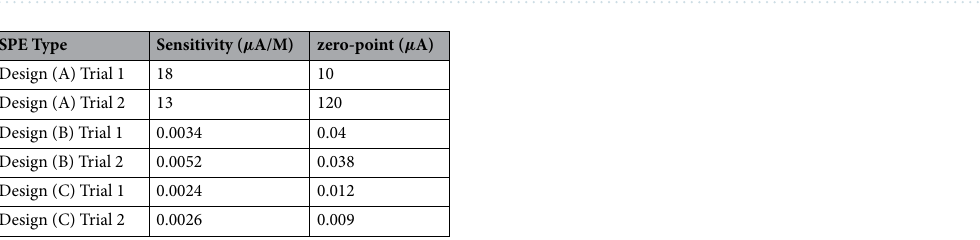
Figure 13. Comparison between potential interferential substances using combination of type (C) fabric and SPE design (C).